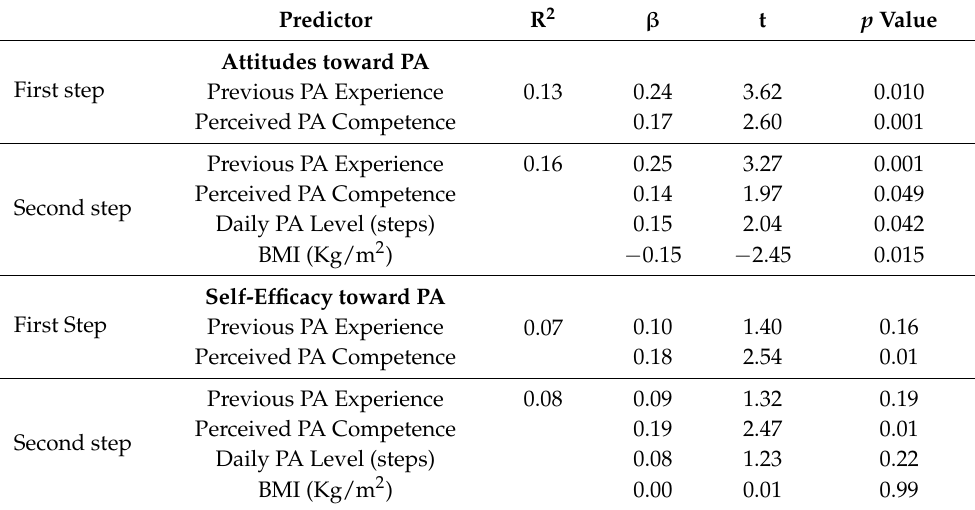
Table 4. Hierarchical Regression